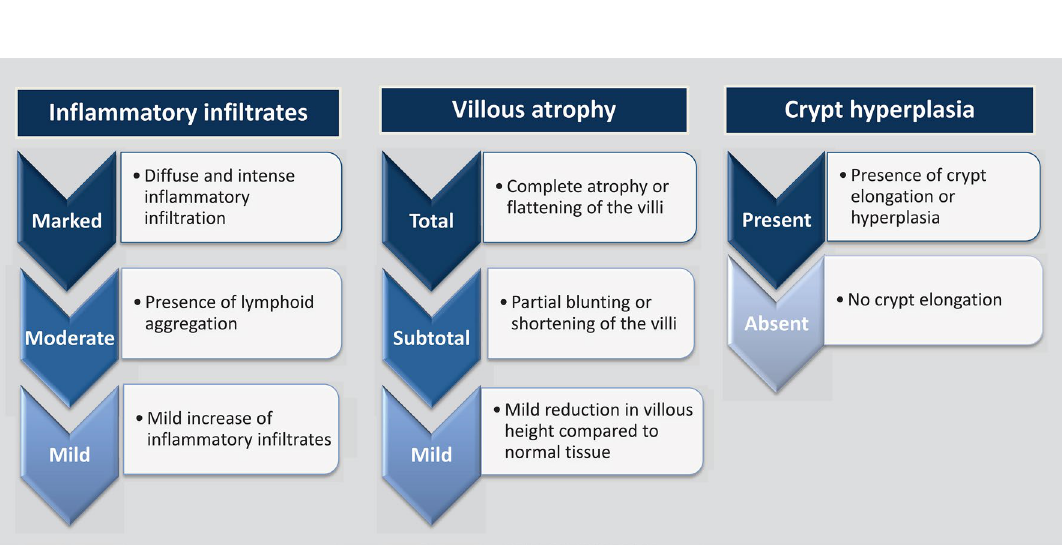
Figure 2. Schematic presentation for assessment of the histological alterations of intestinal